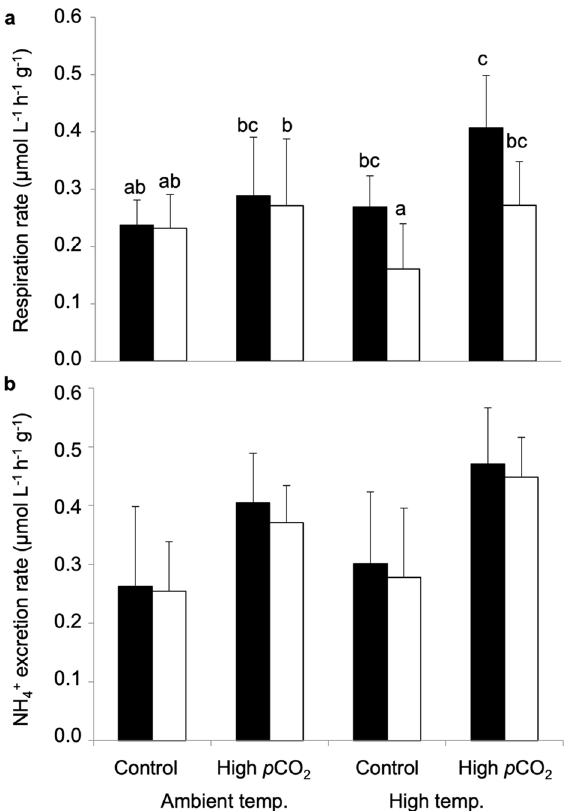
Figure 5. Effect of high temperature (+ 3 °C than ambient) and high p CO 2 (1000 µatm) on respiration and ammonium excretion rates of sea urchin Tripneustes gratilla . ( a ) Respiration rate and ( b ) ammonium (NH 4 + ) excretion rate of T. gratilla fed with experimental (black) and control (white) seagrass. Values represent mean ± SD. Ambient temperature and Control p CO 2 (experimental seagrass: n = 9, control seagrass: n = 9), Ambient temperature and High p CO 2 (experimental seagrass: n = 9, control seagrass: n = 9), High temperature and Control p CO 2 (experimental seagrass: n = 9, control seagrass: n = 8), High temperature and High p CO 2 (experimental seagrass: n = 8, control seagrass: n = 8). Different letters indicate statistically significant among conditions (Tukey’s HSD post-hoc